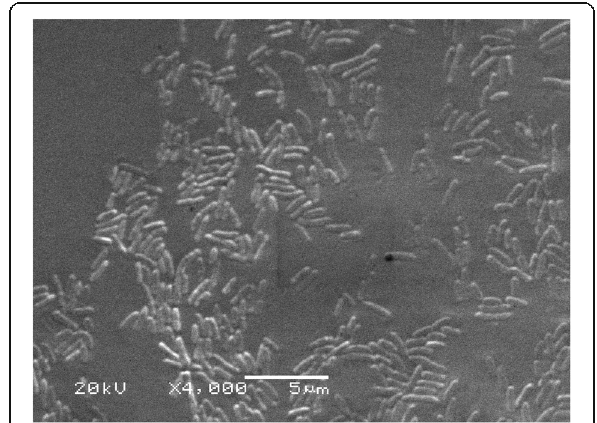
Fig. 1 Scanning electron micrograph of P. steynii DX4